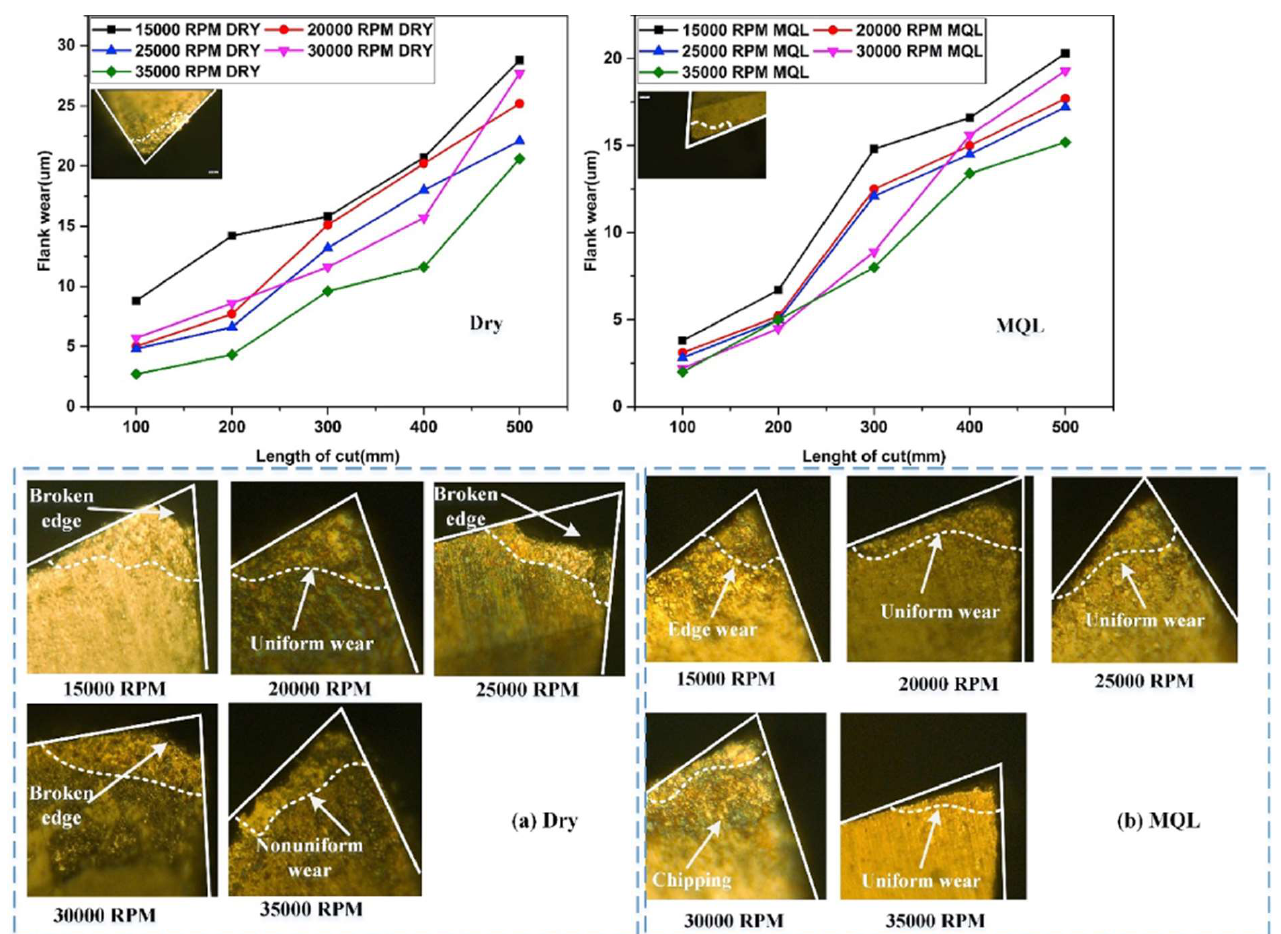
Figure 10. Tool flank wear with increasing feed rate under ( a ) dry conditions and ( b ) MQL coolant conditions [123] (Reprinted with permission from [123]. Copyright 2020, Elsevier).